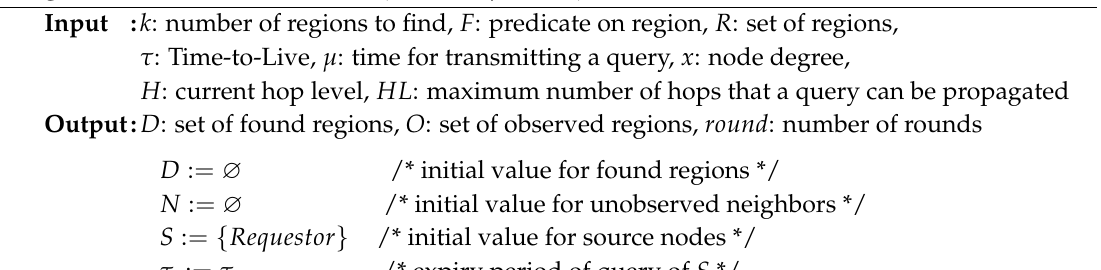
Algorithm 3: Random-X-Walker ( k , F , R , τ , µ , HL , x )